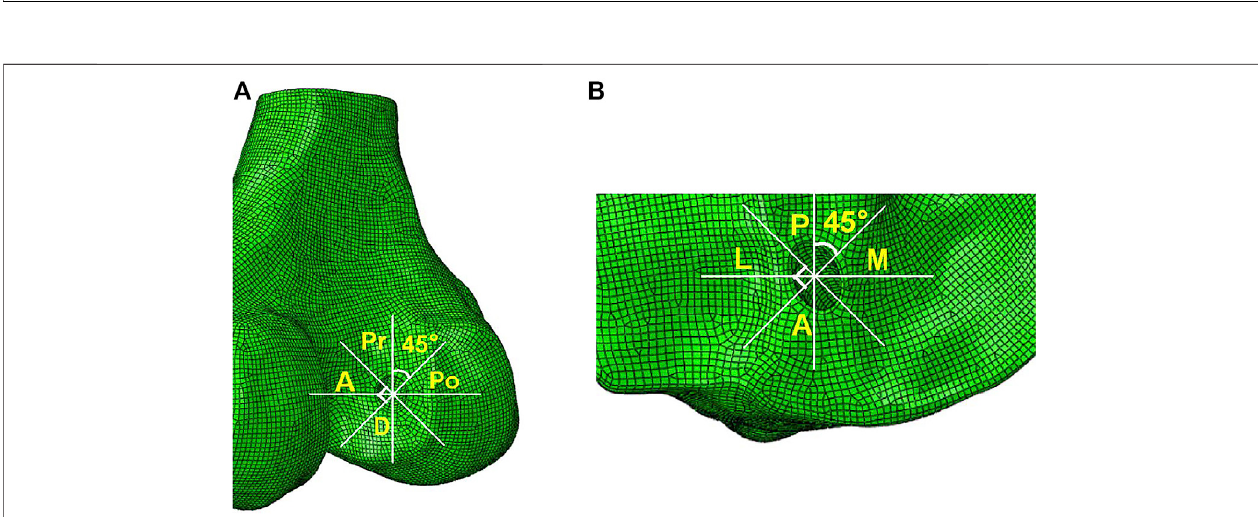
FIGURE 3 | Femoral and tibial tunnel entrances divided into four zones. The two white lines divided the femoral tunnel entrance into four zones: anterior and posterior(AandPo),proximalanddistal(PrandD)zoneforthefemoraltunnelentrance,andanteriorandposterior(AandP),medialandlateral(MandL)zoneforthetibial tunnel